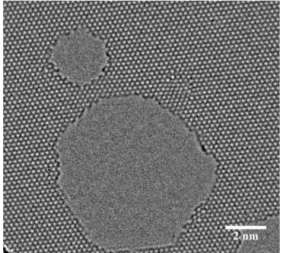
Figure 9. TEM image of small holes on monolayer graphene produced by electron beam sputtering (reprinted with permission from [34]. Copyright 2012 American Chemical